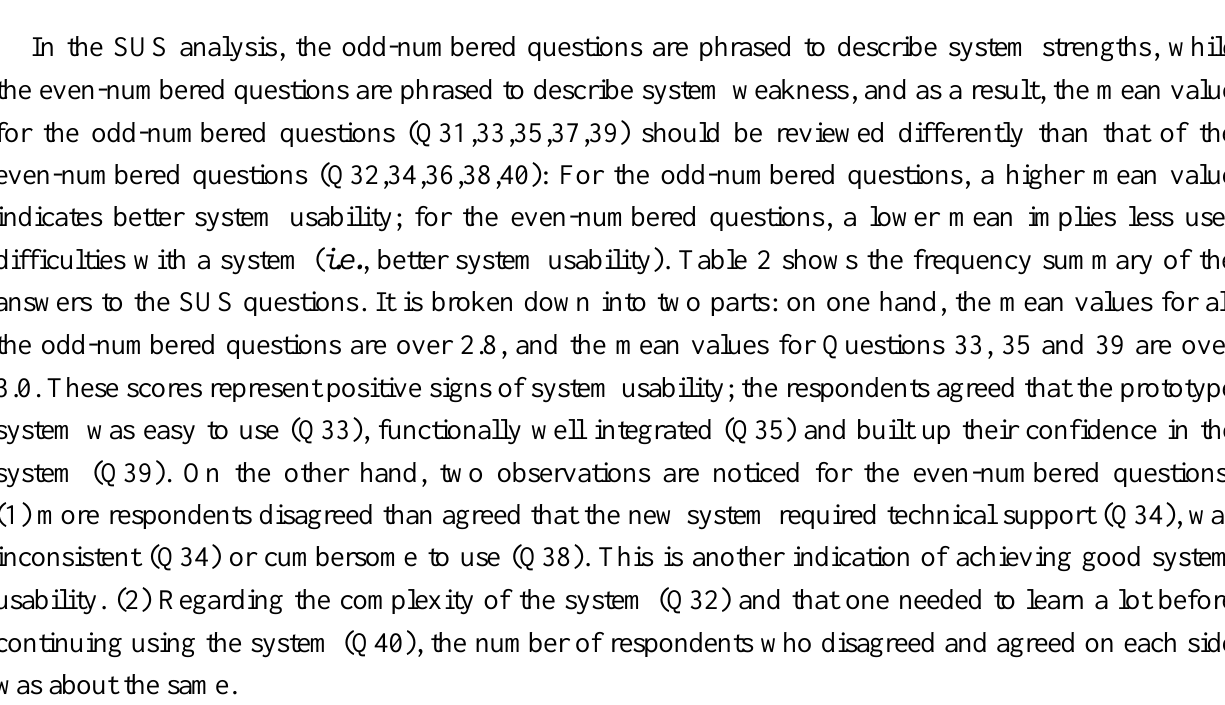
Table 2. Frequency summary of the answers to system usability scale questions. Question